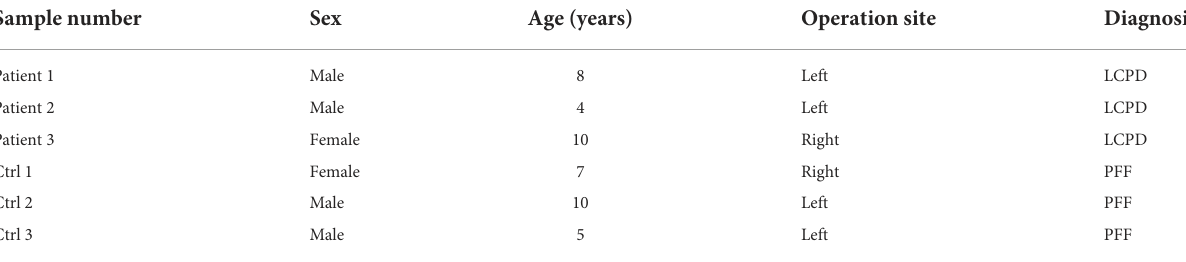
TABLE 2 The main clinical characteristics of the pediatric periosteum samples for qRT-PCR. Sample